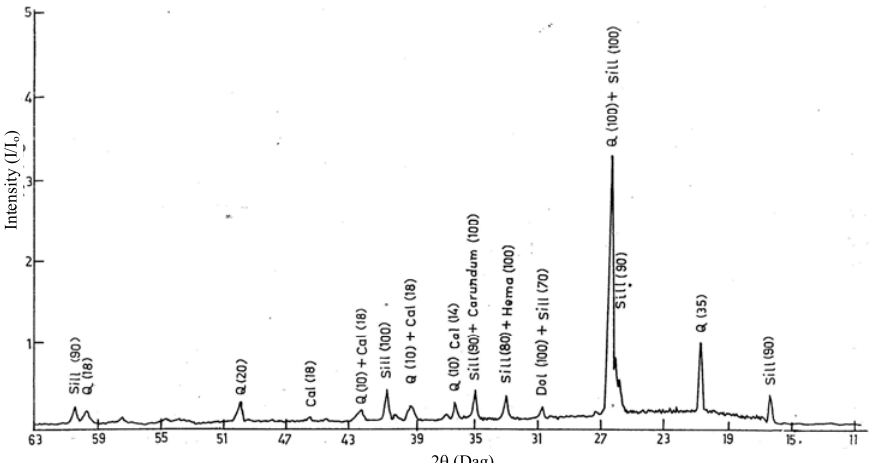
Figure 6. XRD pattern of steam-cured LFAS cube containing nickel hydroxide sludge after leaching with acetic acid- sodium acetate buffer Table 2. Percentage of nickel and chromium leached from LFAS composite in to